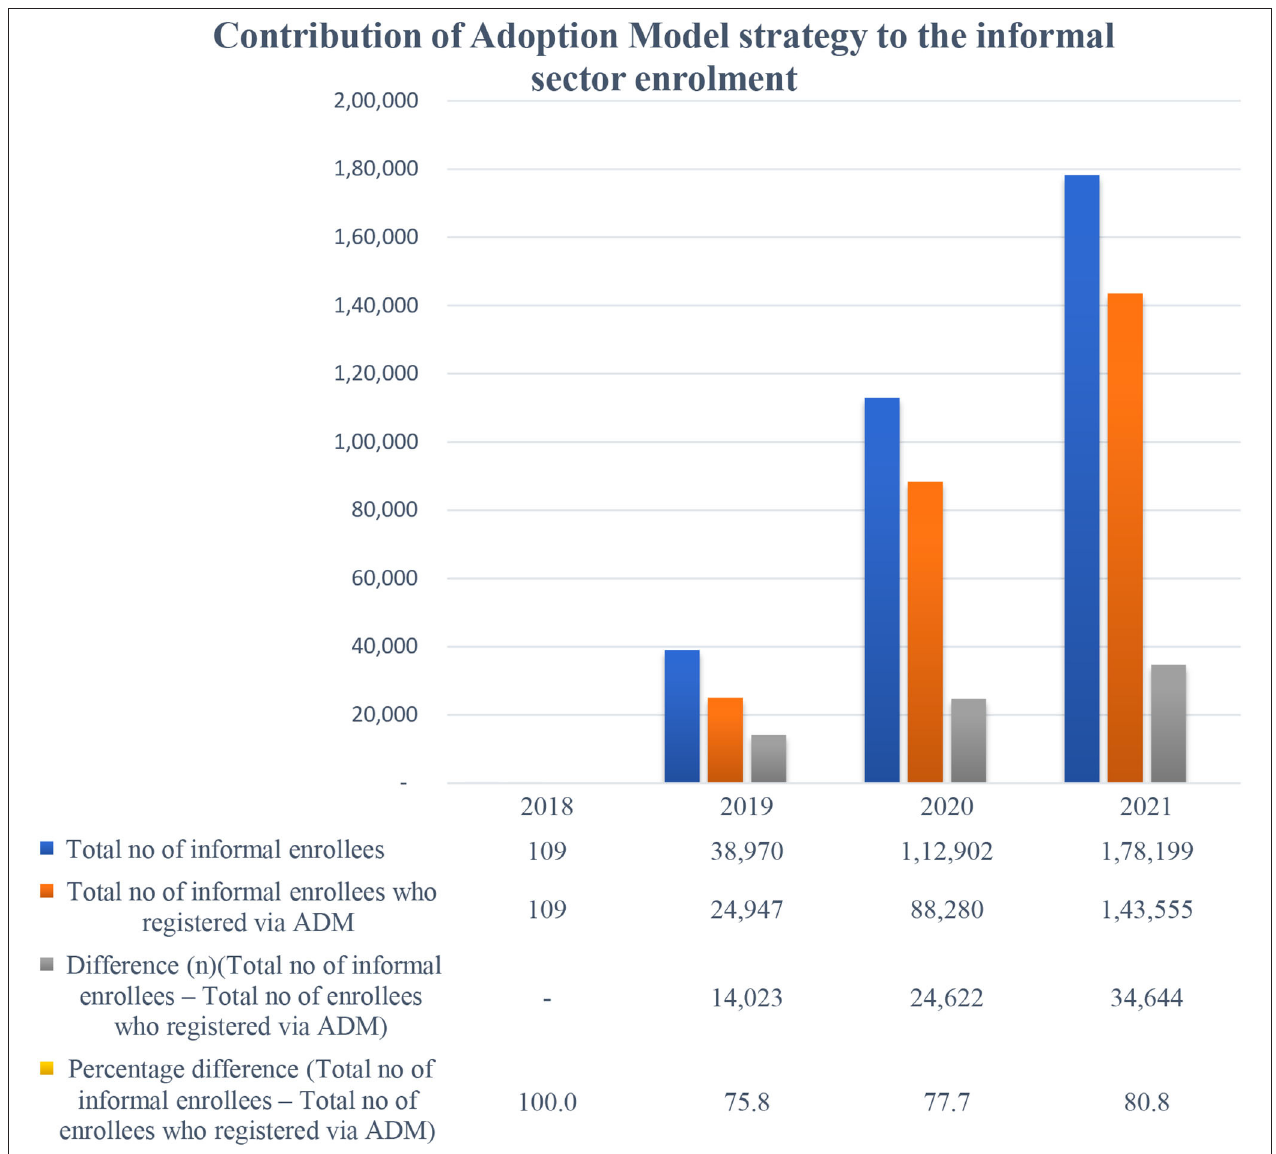
FIGURE 4 | Contribution of adoption model intervention to the informal sector enrollment in Anambra state health insurance scheme between the year 2018 and